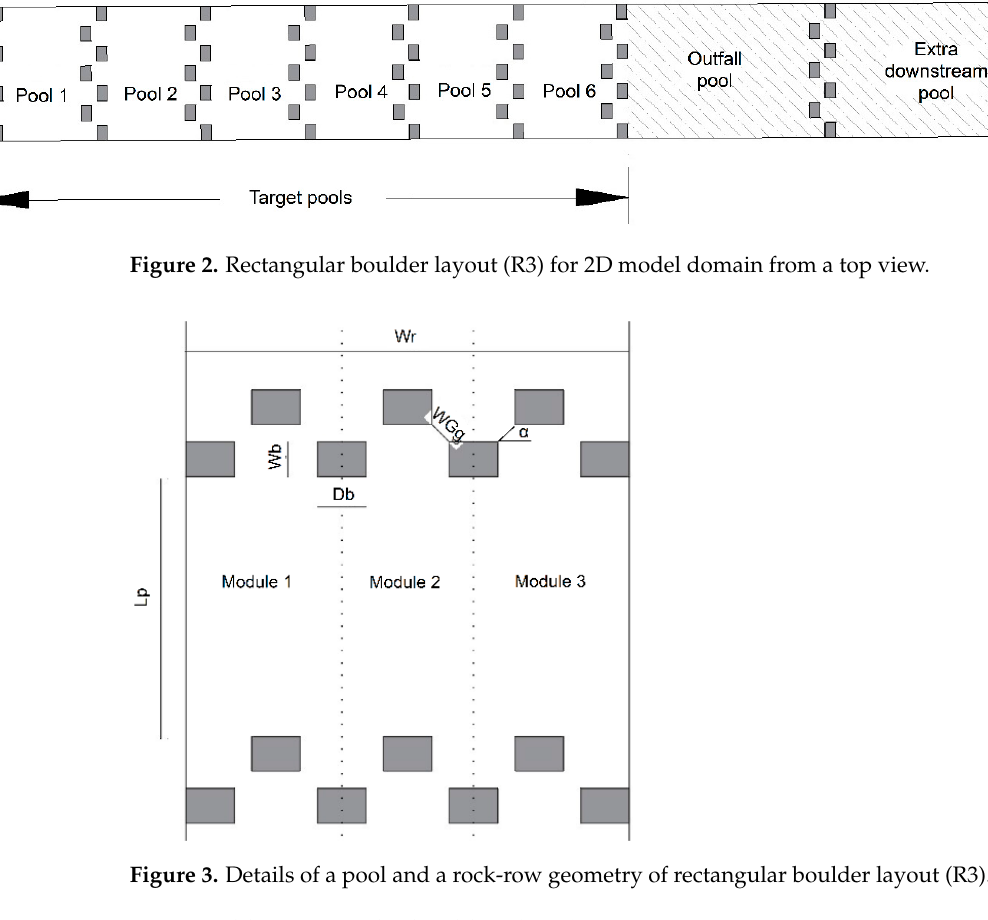
Figure 5. Details of friction walls position of double rectangular boulder with a small barrier layout (DRb3). -